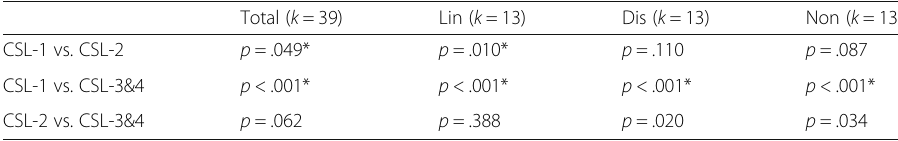
Table 6 Effects of proficiency on comprehension accuracy Total ( k = 39) Lin ( k = 13) Dis ( k = 13) Non ( k = 13) CSL-1 vs. CSL-2 p = .049* p = .010* p = .110 p = .087 CSL-1 vs. CSL-3&4 p < .001* p < .001* p < .001* p < .001*